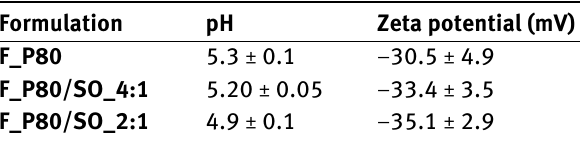
Table 3: Determined pH and zeta potential values of the selected formulations